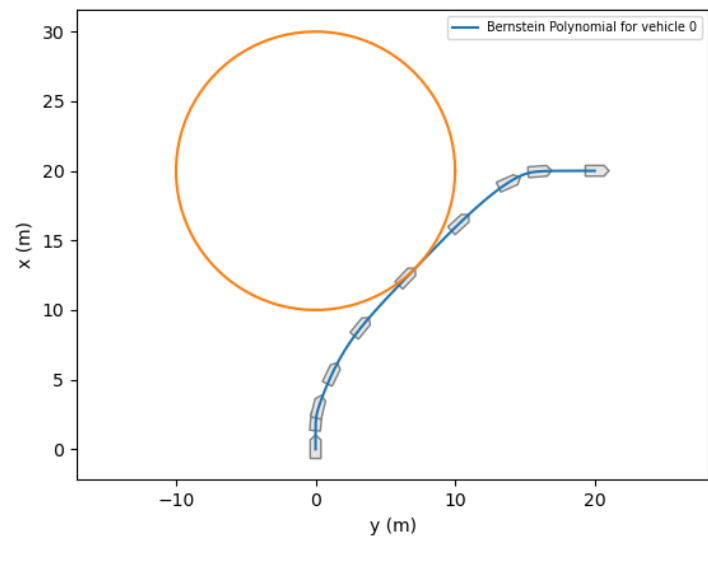
Figure 37. Medusa